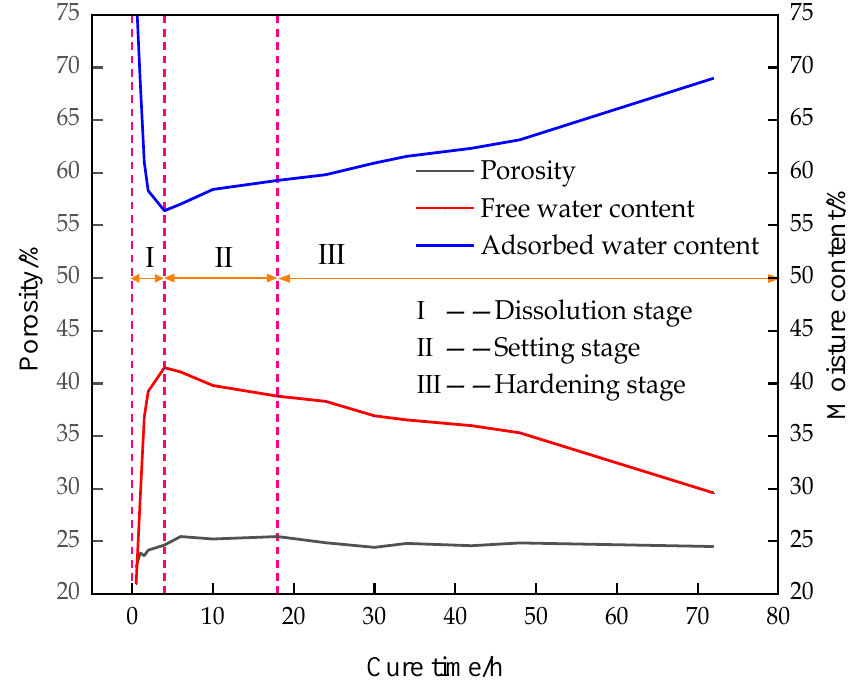
Figure 9. Characteristic curve of porosity and moisture content in different stages.